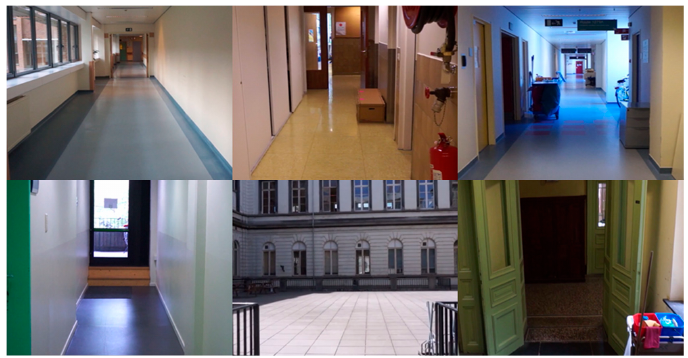
Figure 2. Screenshots videos. From left to right: video 5, 8, 12, 18, 34, 13.